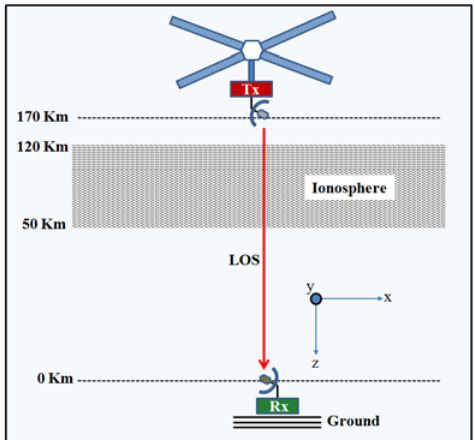
Figure 1. SATCOM Data Link to Ground Receiver